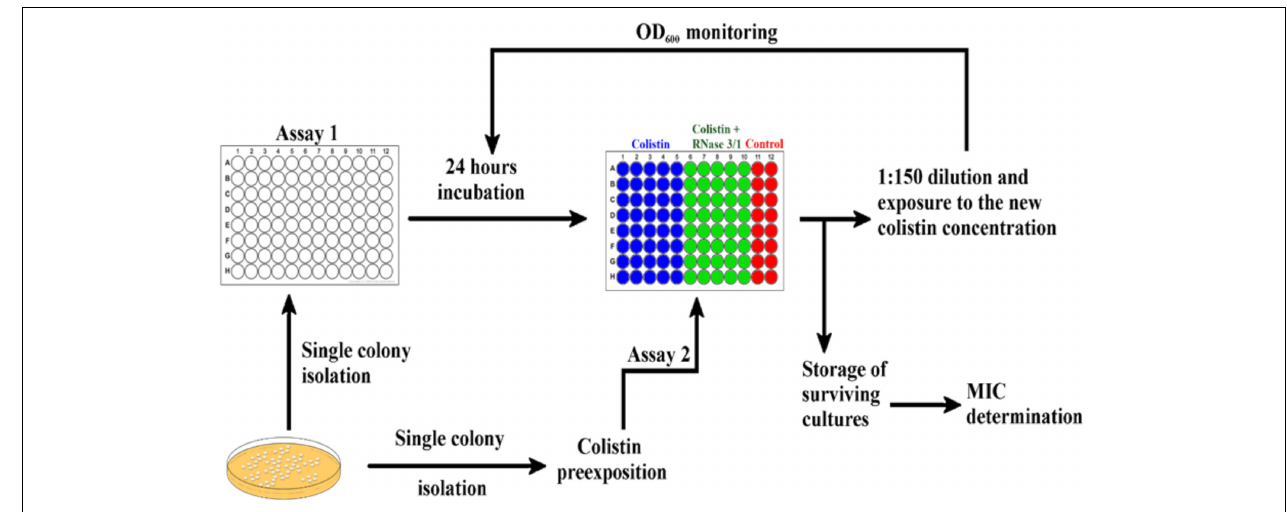
FIGURE 4 | Graphical depiction of the experimental evolution of resistance assay protocol by culture exposure to colistin. 40 parallel lineages of A. baumannii were exposed to colistin or colistin + RNase 3/1. Assay 1 was started from a single colony without colistin preexposure incubated in the presence of 0.1 µ M of RNase